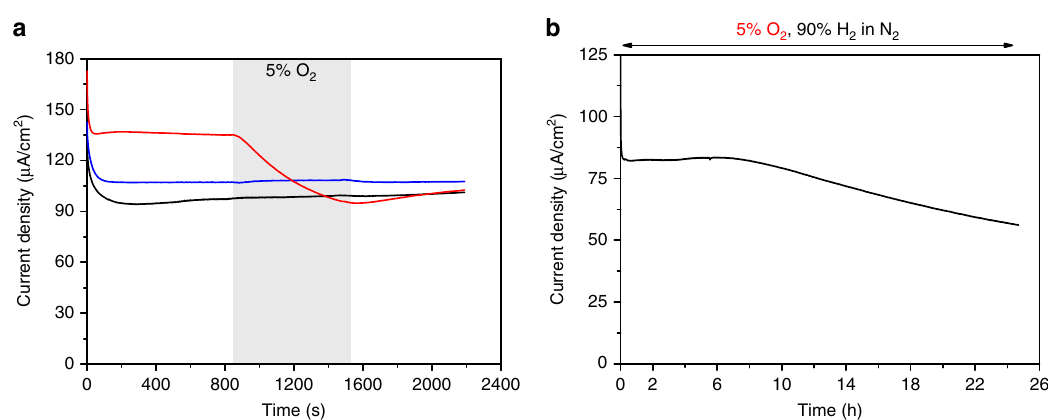
Fig. 4 Catalytic H 2 oxidation by CyGly/polymer fi lms in the presence of O 2 . a Chronoamperometric experiments of glassy carbon electrodes (GCEs) modi fi ed with CyGly/polymer fi lms of different thicknesses obtained by drop-casting 20 µ L (black line), 10 µ L (blue line) and 2.5 µ L (red line) of the CyGly/ polymer solution in acetonitrile onto the GCEs. Measurements conducted under 90% H 2 /10% N 2 with addition of 5% O 2 (90% H 2 /5% N 2 ) over 10 min (shaded area). Conditions: + 541 mV vs. SHE, pH = 3, 0.1 MES/0.1 M HEPES + HClO 4 , 25 °C, 500 rpm. b Chronoamperometric experiment with a